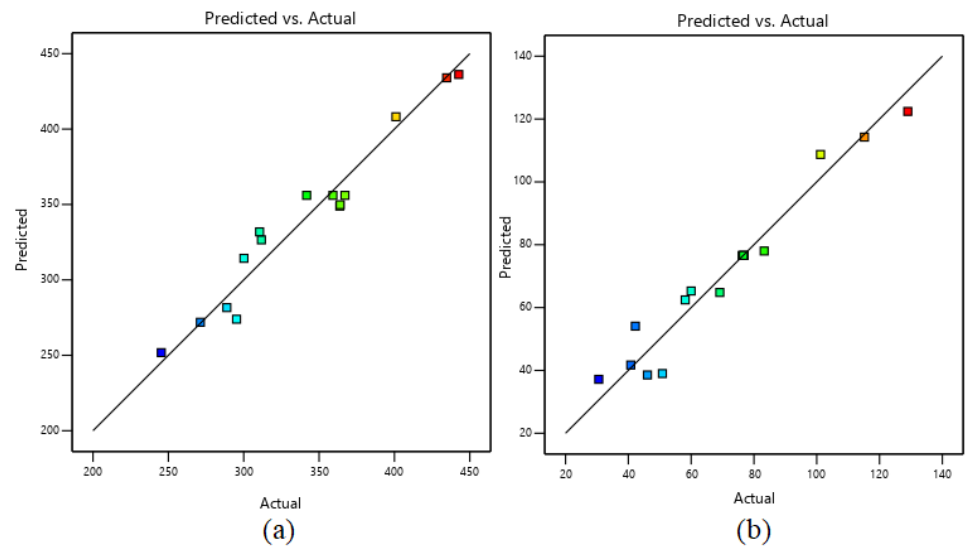
Figure 6. The Box-Behnken experimental versus predicted results: ( a ) temperature; ( b ) power consumption.